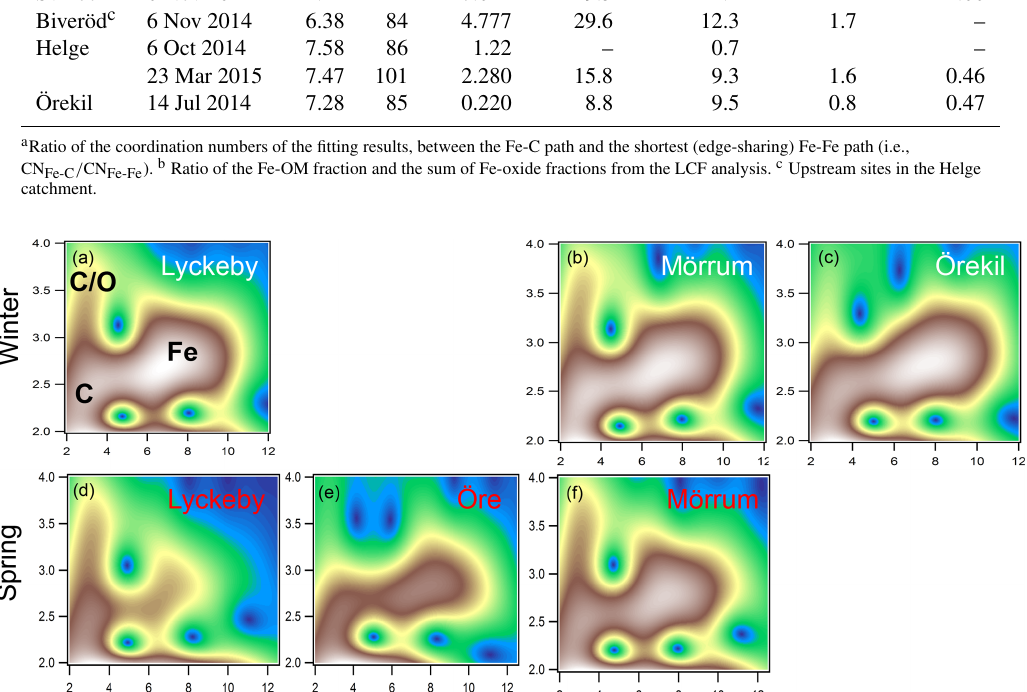
other river mouth samples, a more even contribution of the two Fe species was